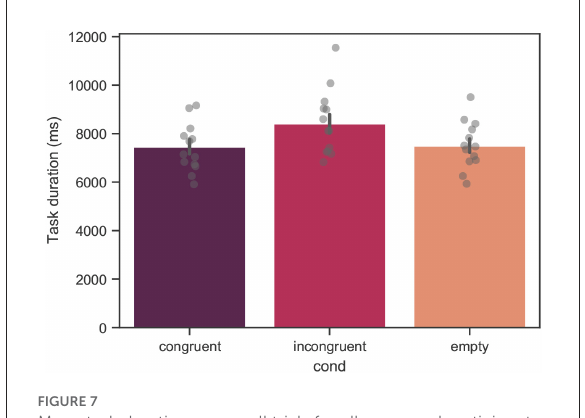
FIGURE7 Mean task duration across all trials for all measured participants. Each bar corresponds to a separate experimental condition. The error bars indicate confidence intervals of 95% computed using bootstrapping (see main text). The individual points correspond to the mean value for each individual subject. The difference between the congruent and incongruent conditions was significant with p < 0.001. The difference between the congruent and empty conditions was not